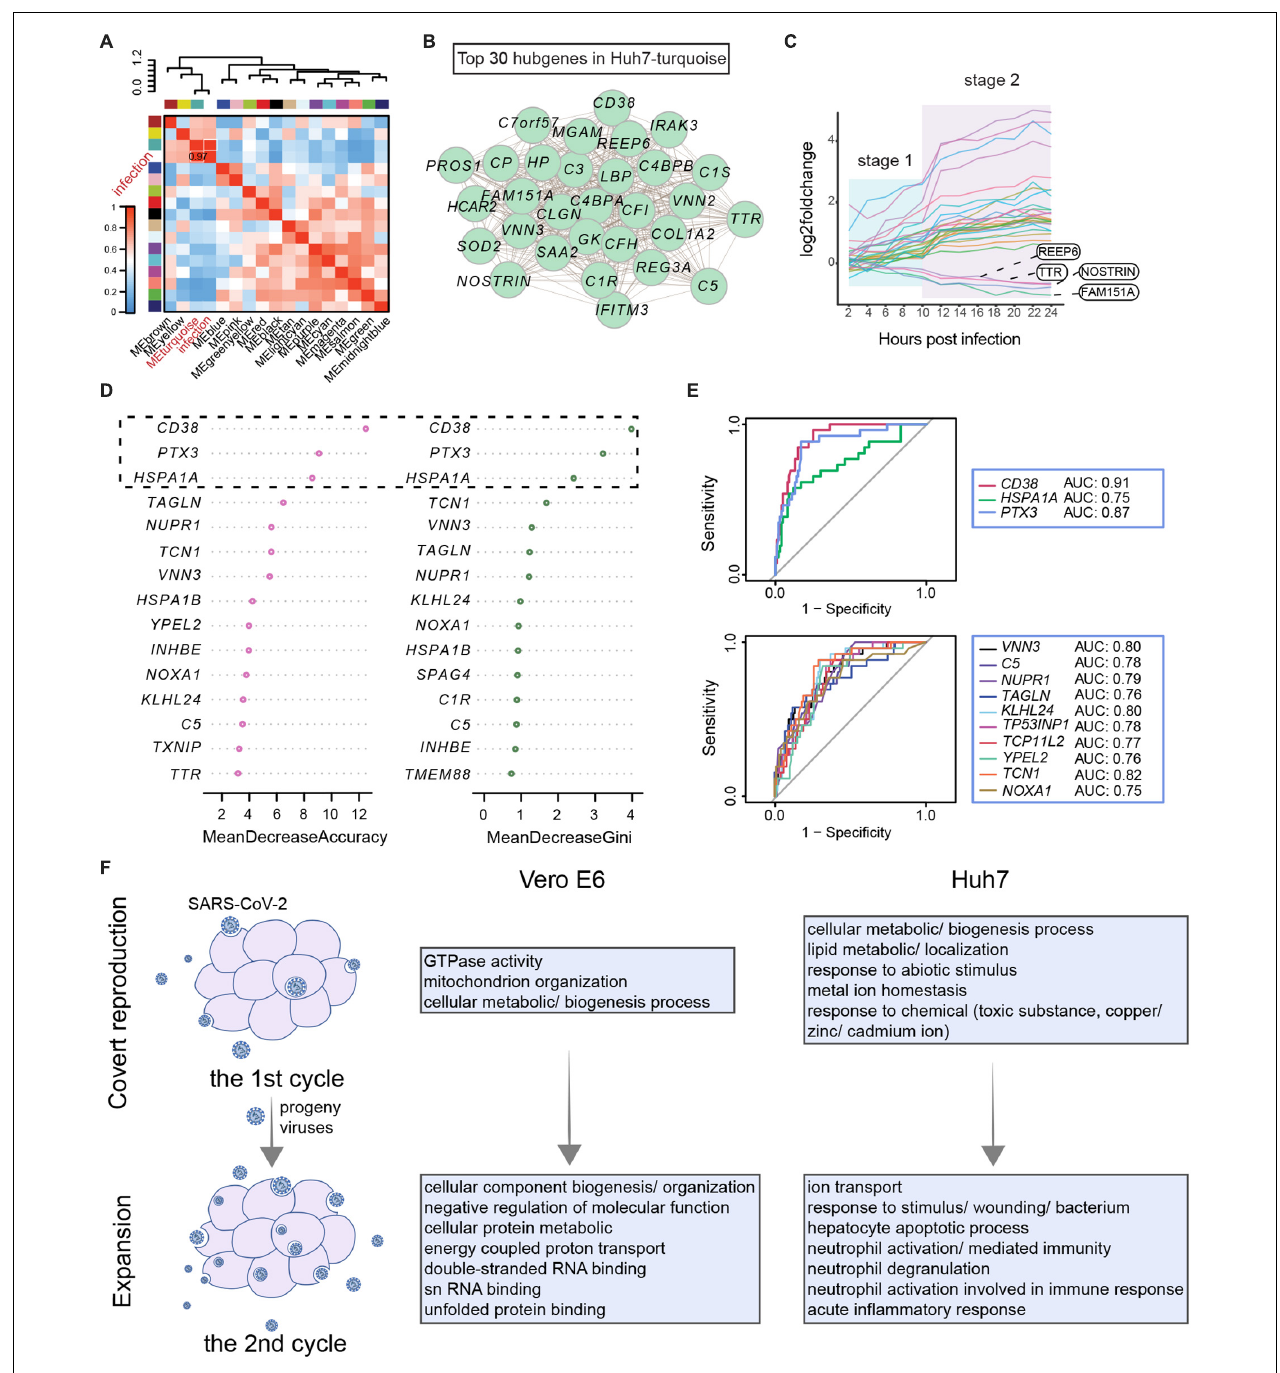
FIGURE 4 | Developmental patterns of co-expression gene modules associated with SARS-CoV-2 infection. (A–C) Weighted gene co-expression network analysis for Huh7. (A) Pearson correlation of gene modules with SARS-CoV-2 infection. (B) Top 30 hub genes in turquoise module associated with infection. (C) Stage-related changes in expression trends of 30 hub genes occurring after 10 hpi. (D , E) Classification model to identify COVID-19 based on core genes. (D) Characterization of core genes in clinical patients. Expression patterns of 79 key genes in COVID-19 and non-COVID-19 patients were evaluated. Then, patients were classified by a random forest algorithm, and classification contribution of each gene was assessed (MeanDecreaseAccuracy and MeanDecreaseGini). Top 15 genes achieved most effective identification are shown here. (E) Receiver operating characteristic curves for genes with good identification of COVID-19 patients. True-positive rate (sensitivity) is represented as vertical coordinate and false-positive rate (1-specificity) as horizontal coordinate. In combination with area under receiver operating characteristic curve, classification effects of core genes were evaluated. (F) Host response pattern differs between first and second rounds of viral infection. Functional enrichment analysis of co-expression modules of genes most affected by virus in first and second rounds of infection reveals cellular state.